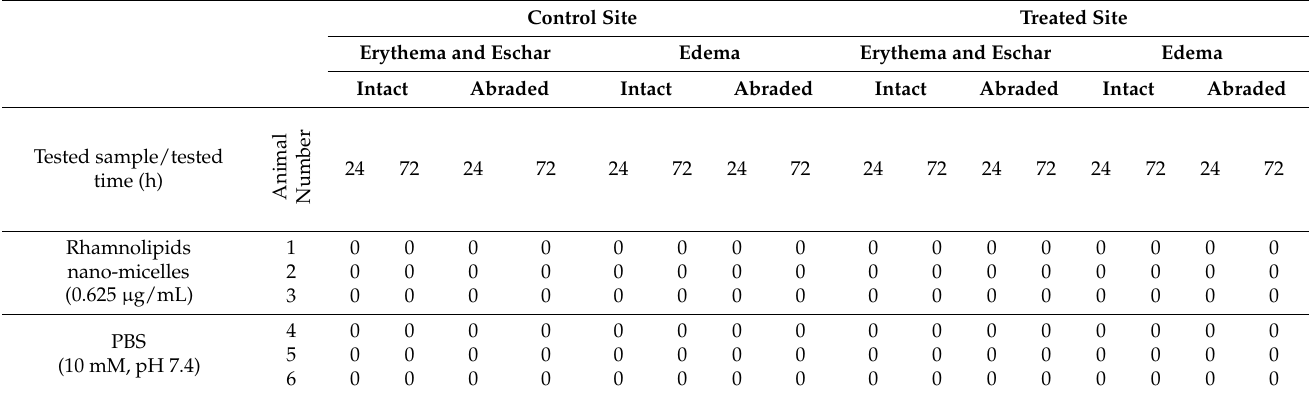
Table 1. Skin irritation evaluation after treatment with rhamnolipids nano-micelles solution and PBS (10 mM, pH 7.4), vehicle used to disperse rhamnolipids nano-micelles *.